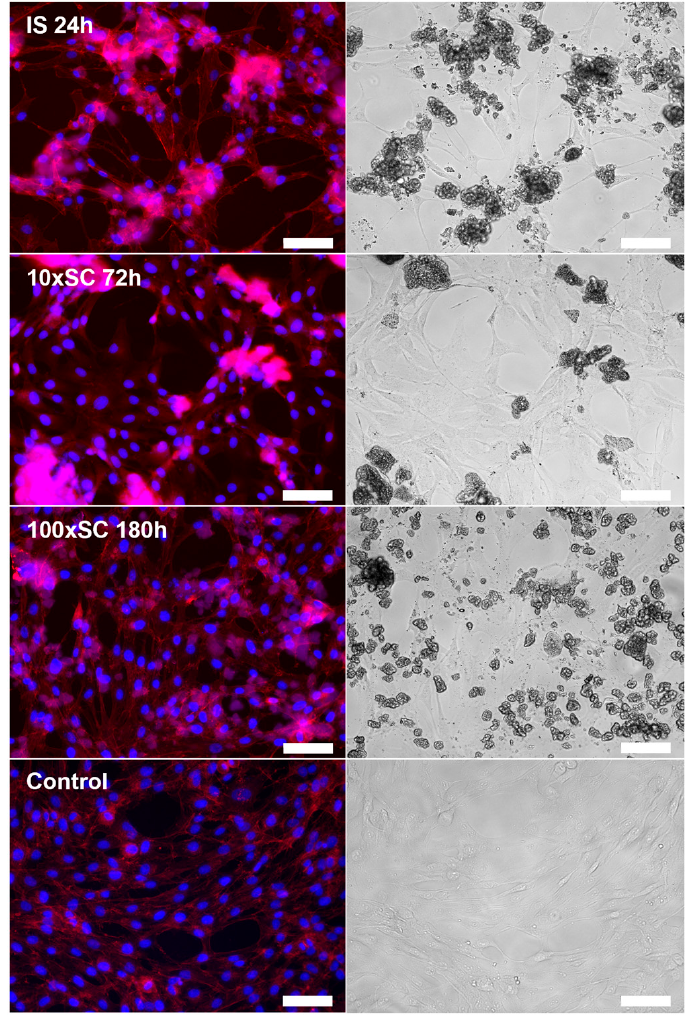
Figure 10. hBMSCs morphology on the third day of cultivation in direct contact with final OCP samples (IS, 10 × SC and 100 × SC) in the concentration of 0.5 mg/mL. Control represented cells on polystyrene. Immunofluorescent ( left column) and bright-field ( right column) microscopy. Image bar scale: 125 μ m.